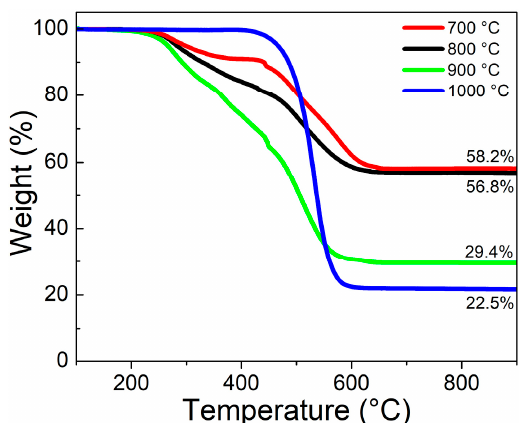
Figure 8. Thermogravimetric analysis (TGA) results of DLICVD experiments, performed at an aspiration temperature of 225 ◦ C, a 1 mL/h injection rate, a 1.25 wt.% catalyst concentration, using EtOH as a carbon source, and a reaction temperature of 700 ◦ C (red), 800 ◦ C (black), 900 ◦ C (green), and 1000 ◦ C (blue) with the corresponding residual weights